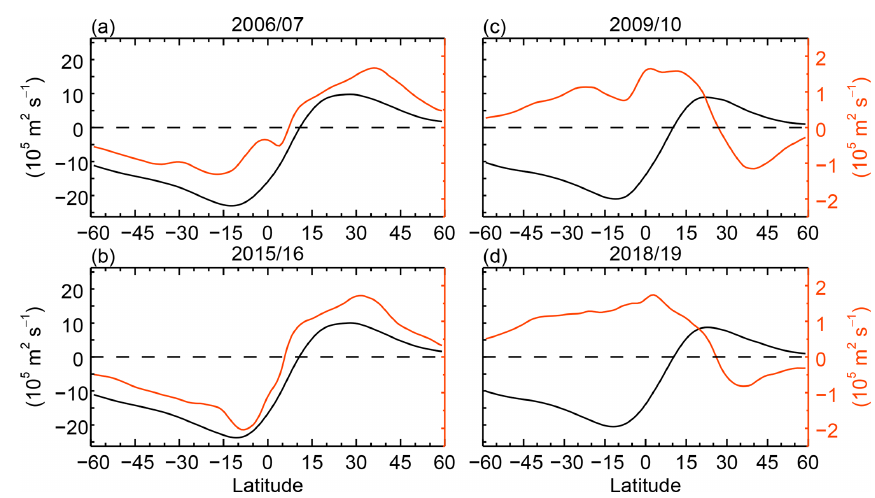
Figure 6. Velocity potential (black) and anomaly index (orange) of the Hadley circulation at 850hPa derived from reanalysis data in the (a) 2006/07, (b) 2015/16, (c) 2009/10, and (d) 2018/19 winters.